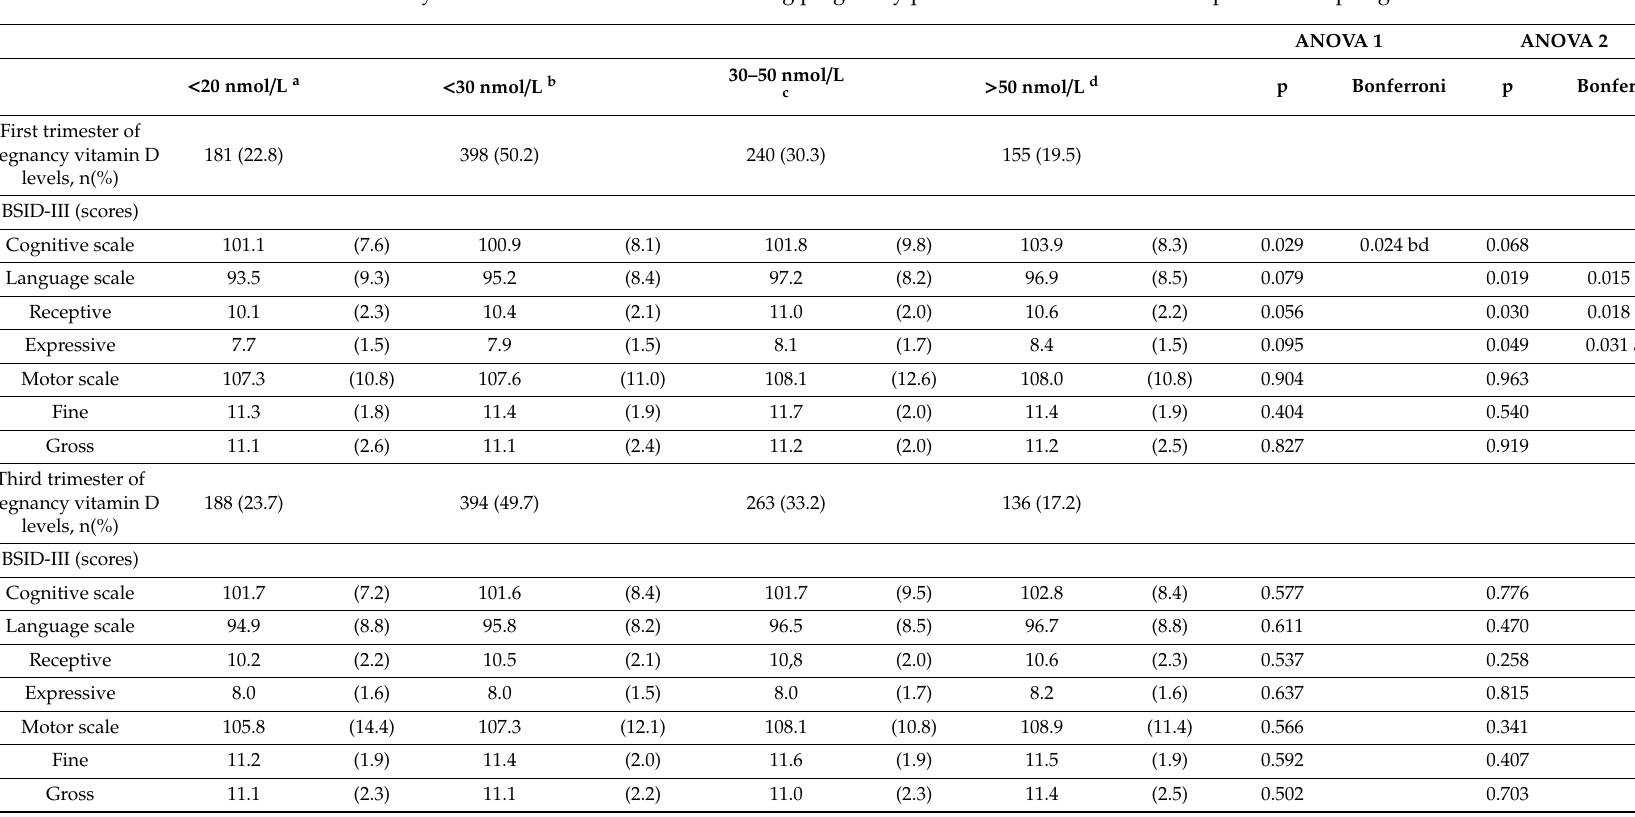
Table 3. Bivariate analyses between vitamin D levels during pregnancy per trimester and neurodevelopmental o ff spring data.